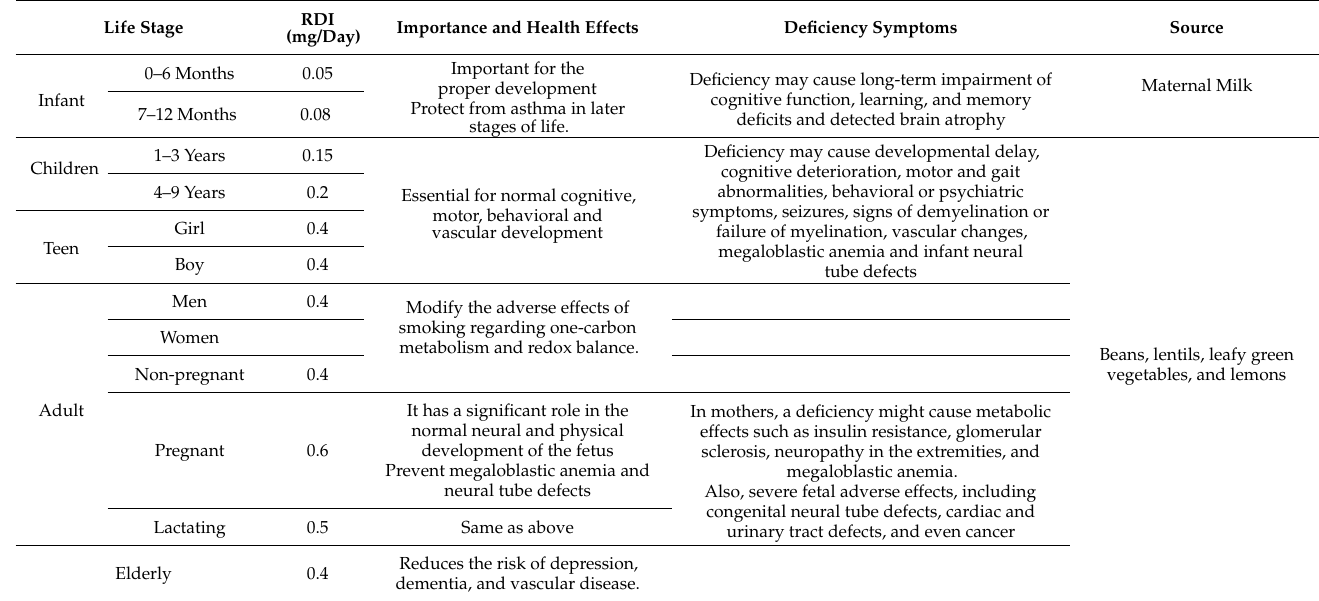
Table 7. Recommended daily intake (RDI), main actions, and natural sources of vitamin B9 (folic acid) in different life